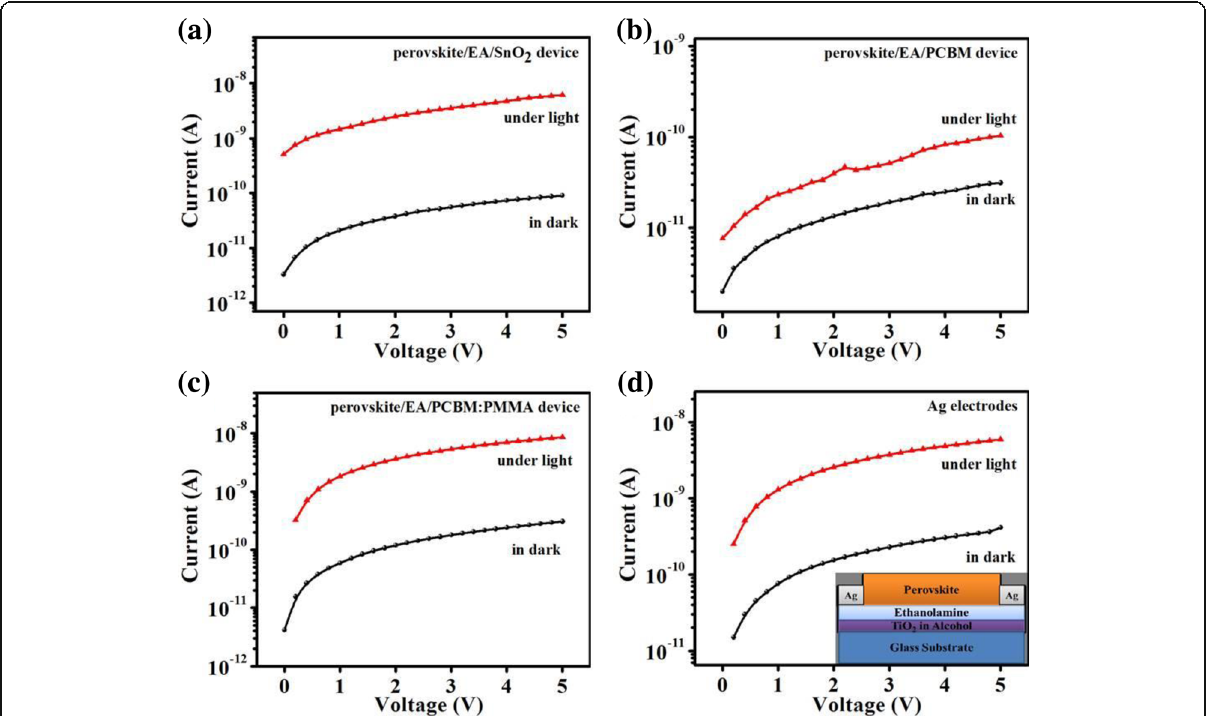
Fig. 8 I – V curves. a The perovskite/EA/SnO 2 device. b The perovskite/EA/PCBM device. c The perovskite/EA/PCBM:PMMA device. d The perovskite/EA/TiO 2 device with Ag